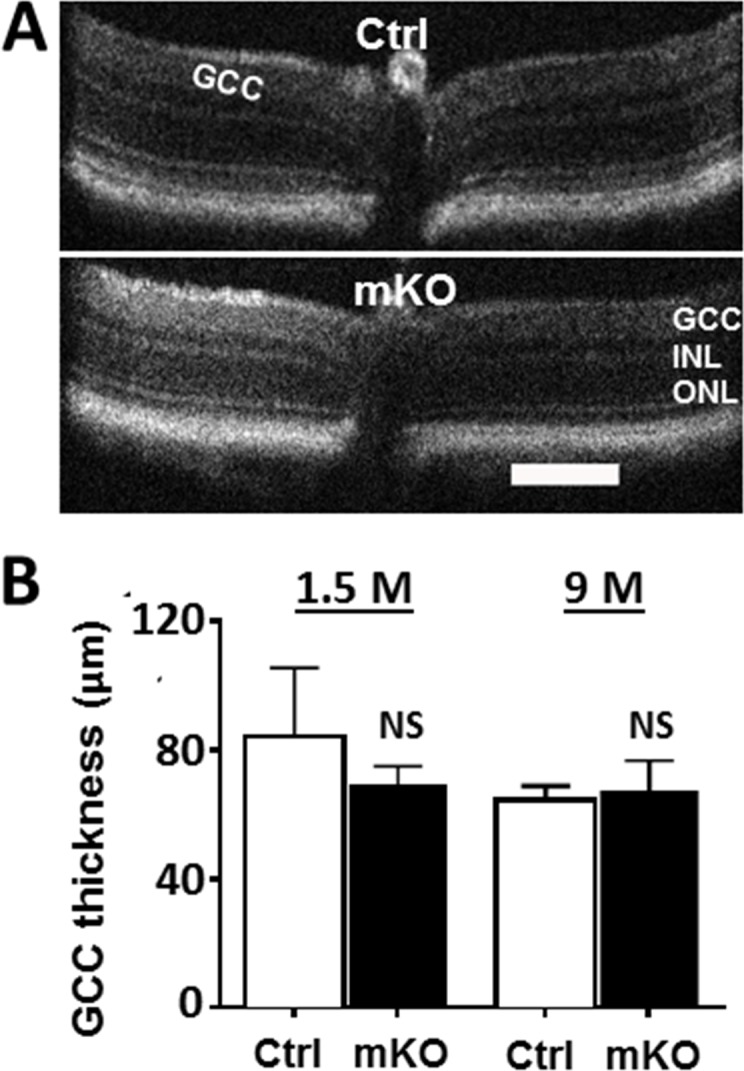
Retinal morphology in mKO and littermate control mice assessed by SD-OCT.(A) Representative radial volume scans of the floxed control and mKO mouse retinas with SD-OCT. No apparent defects were noted. Scale bar: 200 μm (B) Quantification of GCC thickness. No significant difference (NS) was noted between the floxed and mKO mice at either 1.5 or 9 month old (n = 8/group; P > 0.05 by two-tailed student t test).